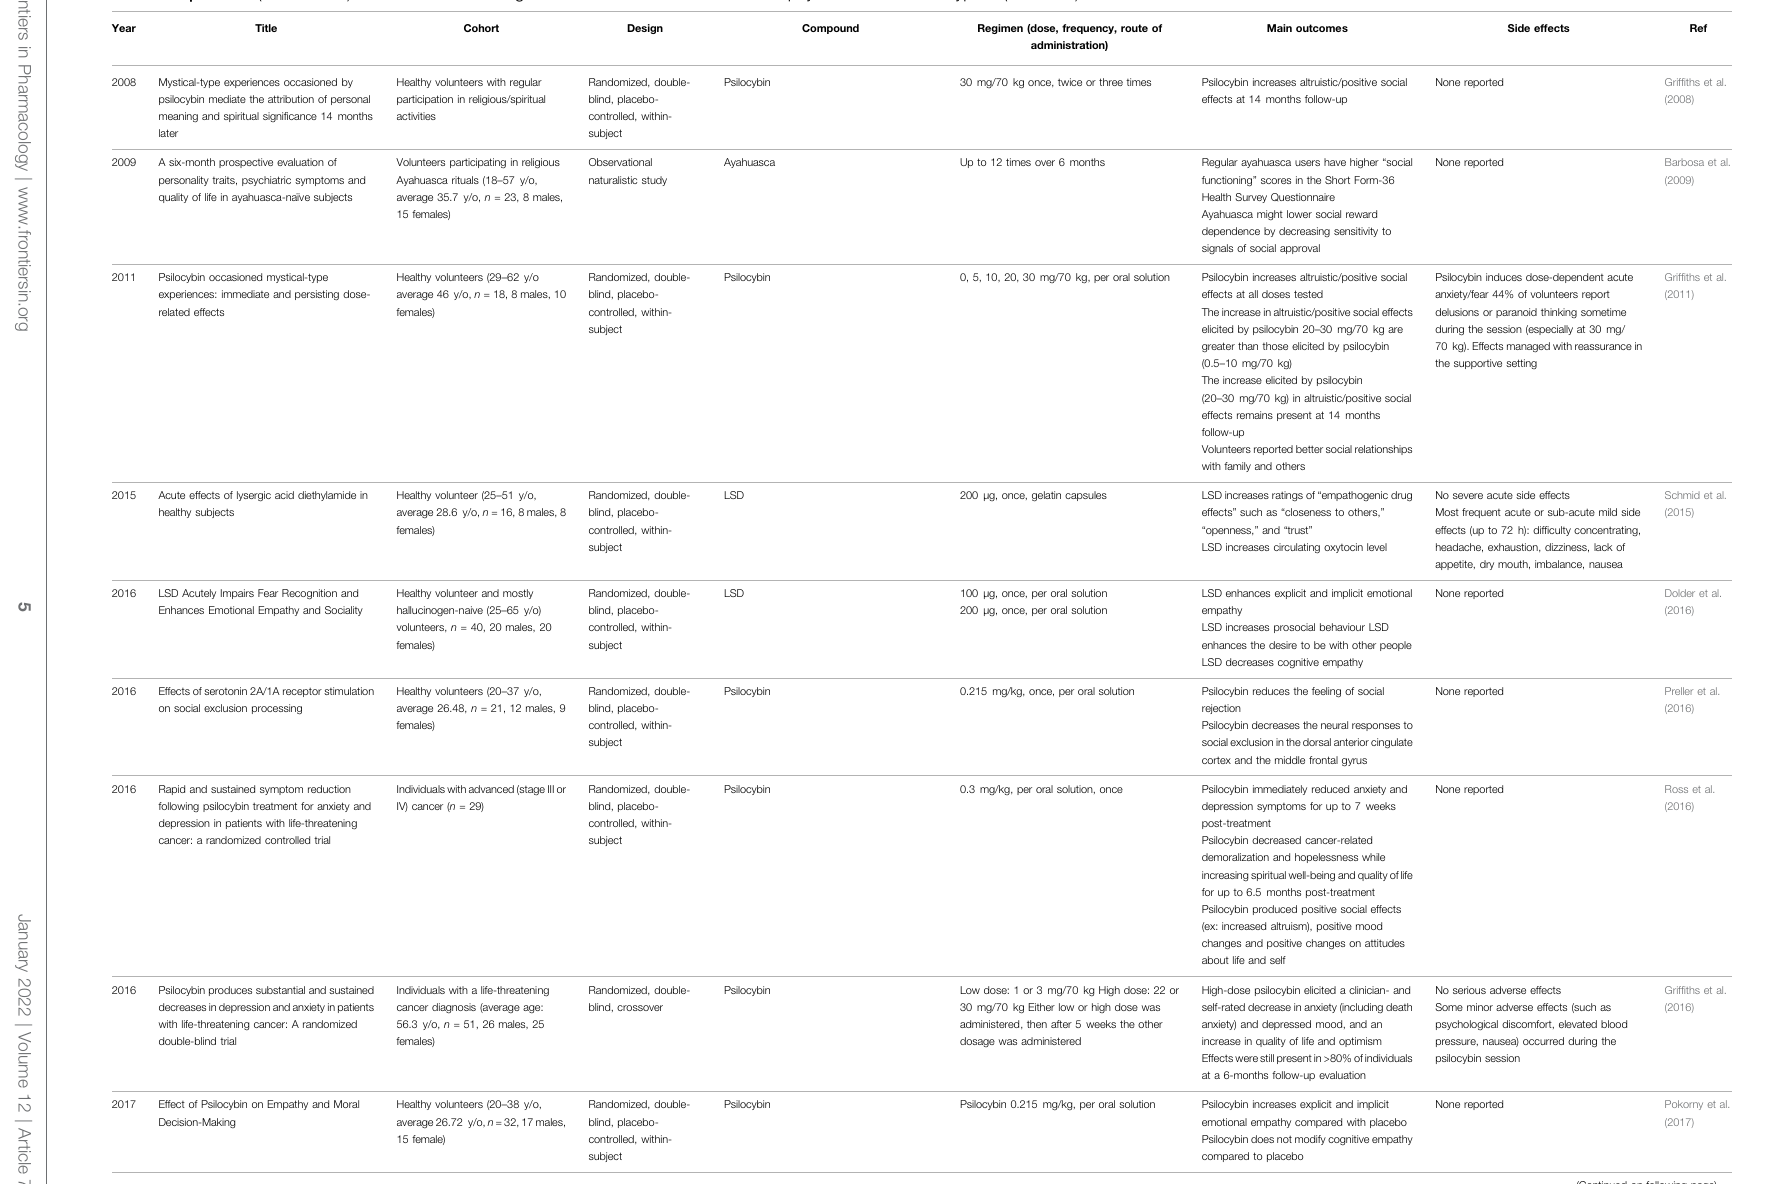
TABLE 1 | Recent (2008 – 2021) clinical trials assessing social behaviour-related effects of psychedelics in neurotypical (non-ASD)